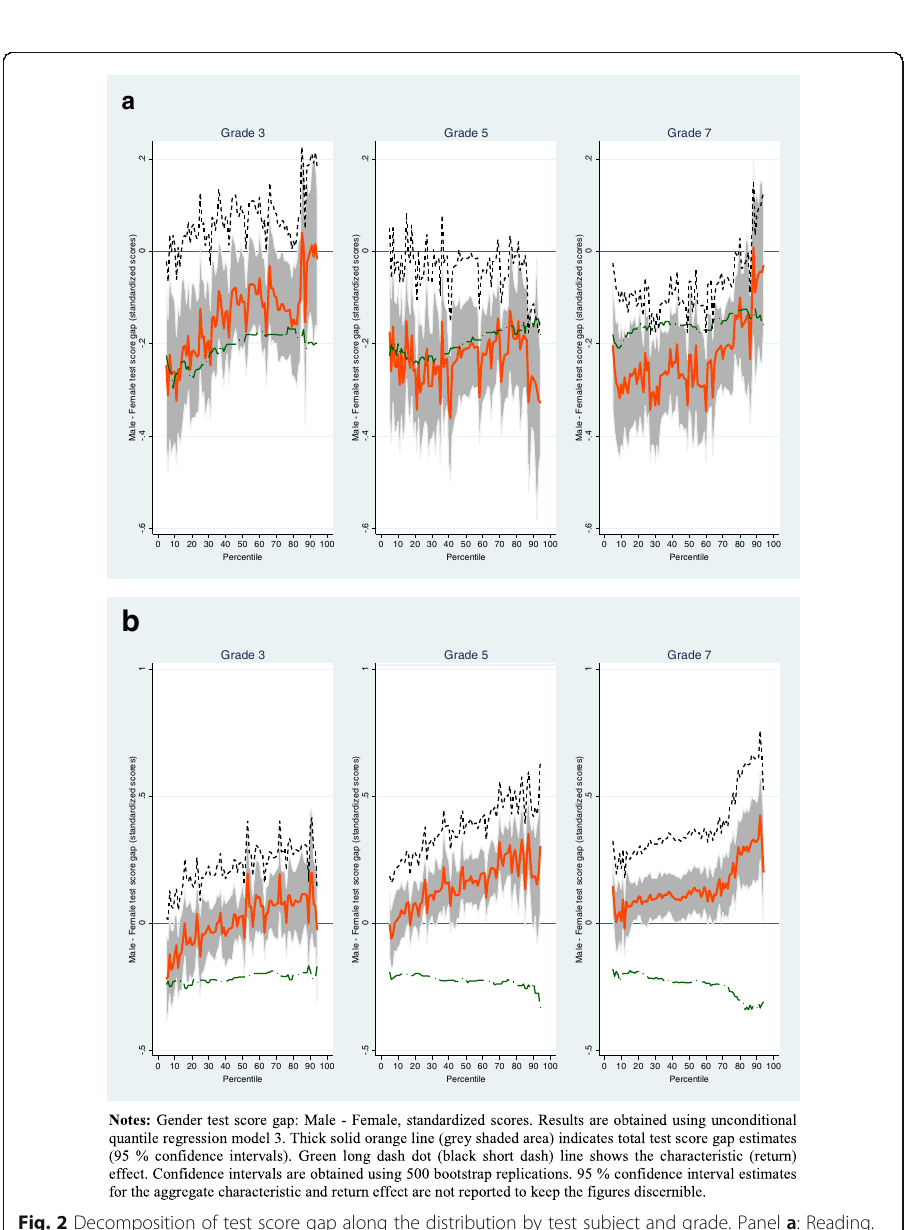
Fig. 2 Decomposition of test score gap along the distribution by test subject and grade. Panel a : Reading. Panel b :